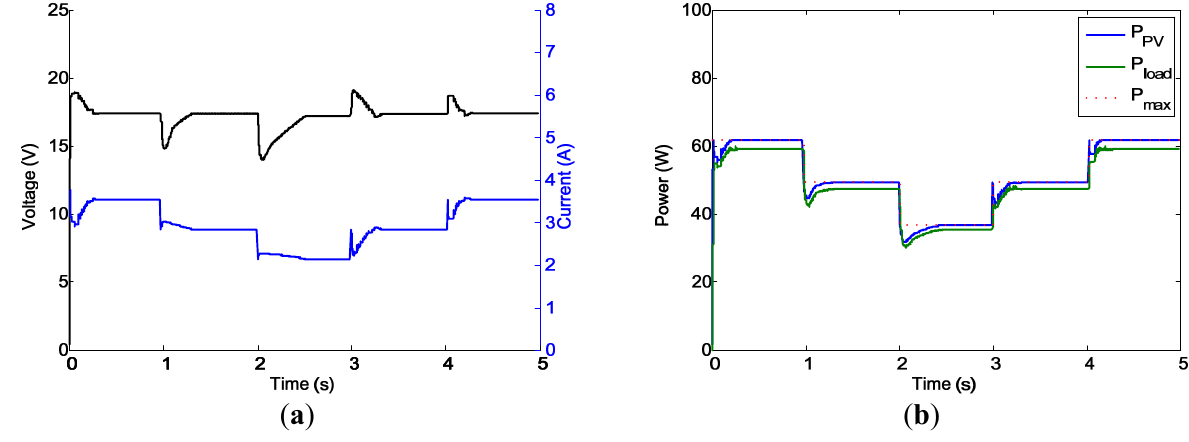
Figure 19. Circuit simulation for irradiation variations using Zeta converter. ( a ) Voltage and current from PV model; ( b ) Power output from PV model and power at the load terminal.